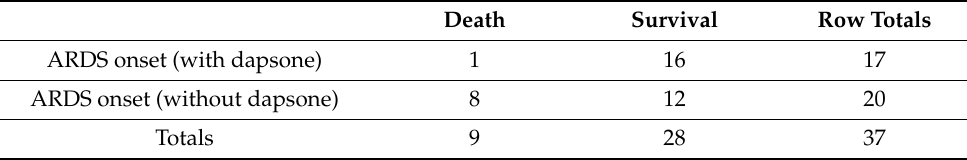
Table 6. Chi-squared test for